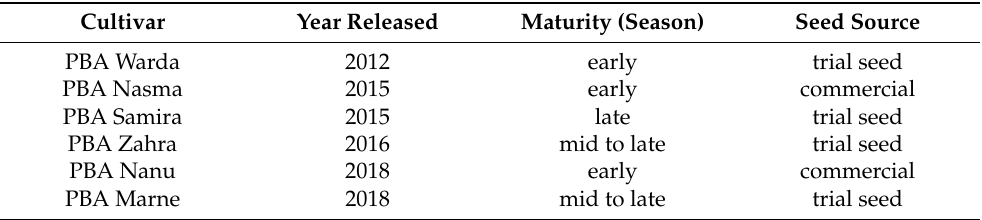
Table 1. Faba bean cultivars characteristics and source of seed used in pot studies conducted at Narrabri and Toowoomba.